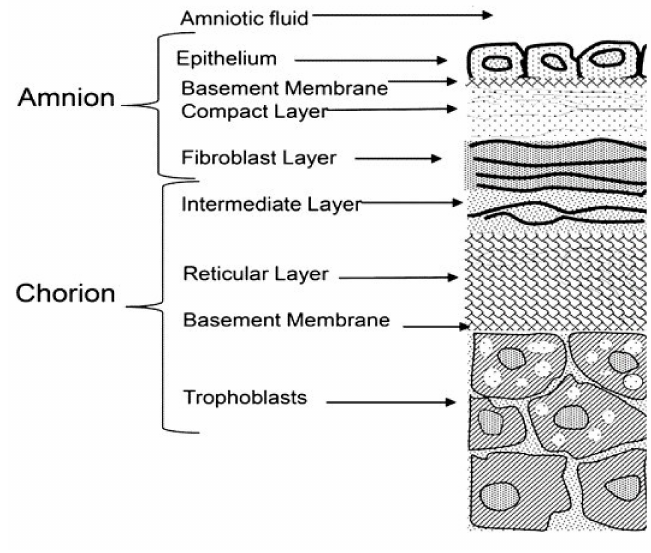
Figure 1. Schematic representation of the layered structure of the amniotic membrane